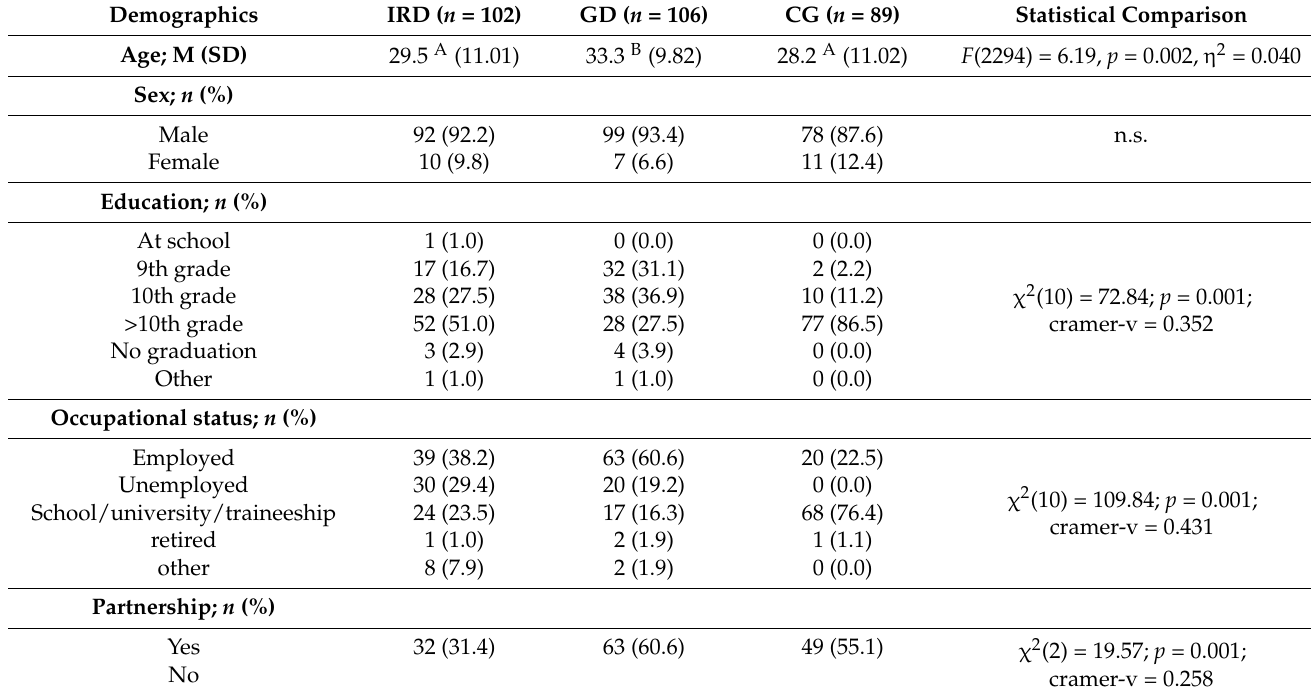
Table 1. Sociodemographic characteristics of the treatment seekers and the control group.